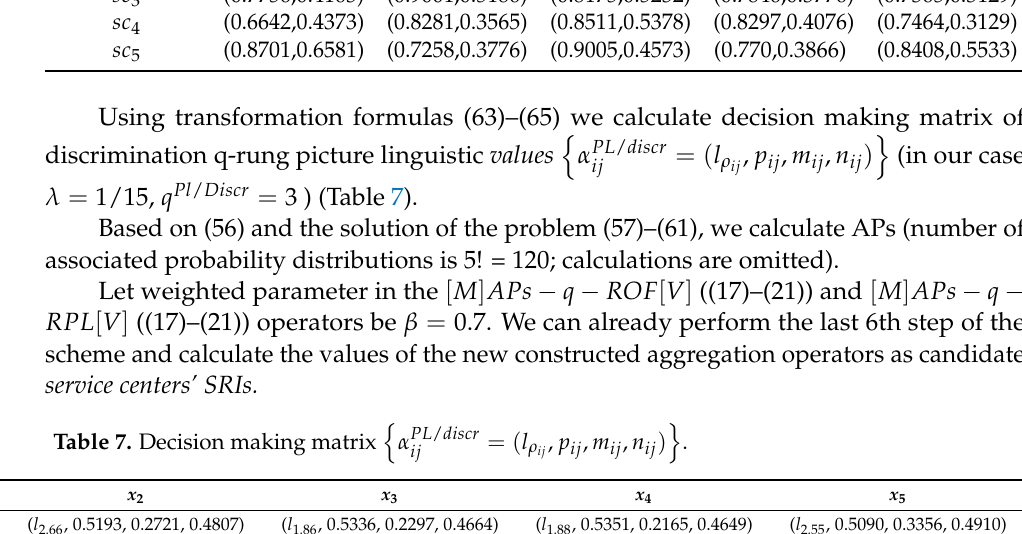
Table 7. Decision making matrix